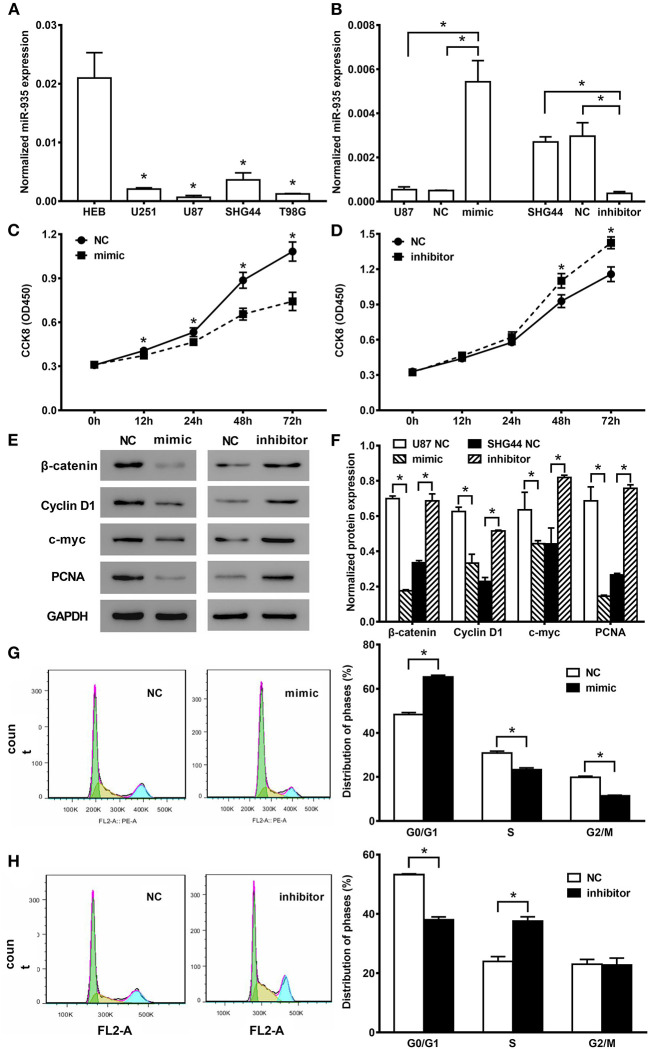
MiR-935 modulates cell proliferation and cell cycle in human glioma cell lines. (A) The quantitative PCR (qPCR) analysis showed the relative expression of miR-935 in the human glioma cell line, *p < 0.05, when compared to normal human glioma HEB cell line. (B) The qPCR analysis showed that miR-935 mimics enhanced the miR-935 expression in U87 cells and the miR-935 inhibitor-depressed miR-935 in SHG44 cells. The cell counting kit8 (CCK8) assay showed that the miR-935 mimic (C) significantly decreased the U87 cell proliferation, and the miR-935 inhibitor (D) significantly increased the SHG44 cell proliferation; *p < 0.05 at indicated time points. (E) The representative Western blotting of proliferation-related biomarker in the miR-935 mimic- or the inhibitor-treated glioma cell lines. (F) The bar chat showed the expression of β-catenin, cyclin D1, c-myc, and PCNA protein in the miR-935 mimics or inhibitor and respective NC transfected cells; *p < 0.05 between indicated groups. Values are the mean ± SD normalized micro-RNA or protein expression or relative cell counting presented by the CCK8 assays. (G) MiR-935 mimics significantly increased the cell circle G0/G1 phase transition in U87 cells and decreased the S phase and the G2/M phase cell distribution. (H) MiR-935 inhibitor depressed the proportion of the G0/G1 phase cells in the SHG44 cell line. The percentage of cells in the S phase was increased; *p < 0.05 between the indicated groups in the unpaired Student's t-test.